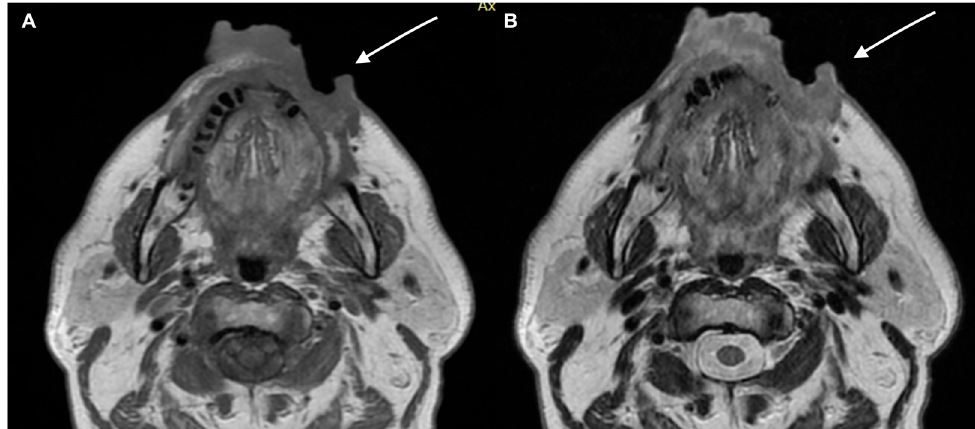
Figure 4. A 65-year-old male patient MRI examination. Lesion interesting the cutaneous and subcutaneous tissues without involving the bone tissue. ( A ) T1 weighted imaging and ( B ) T2 weighted imaging.